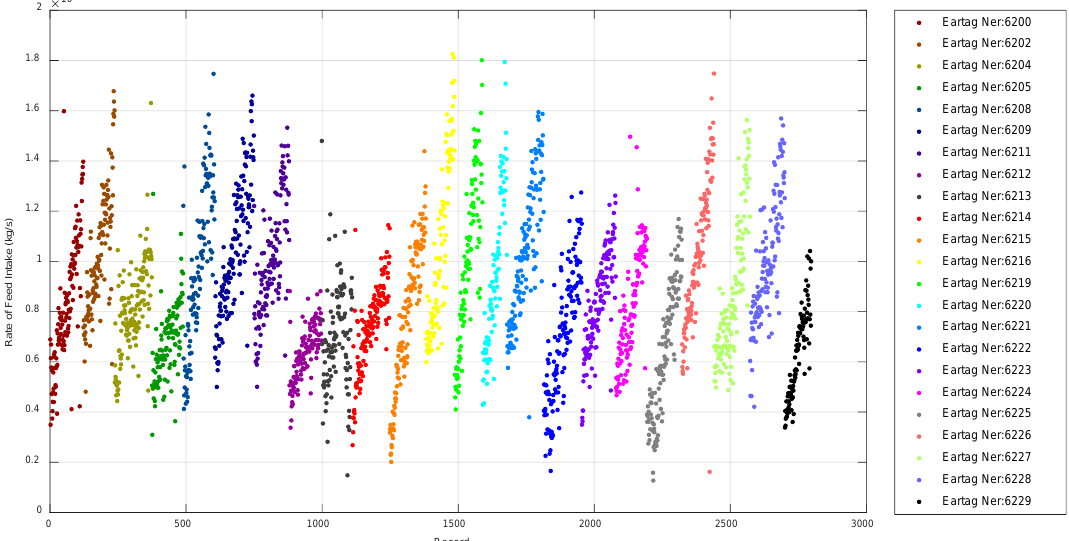
Figure 12. Evolution of the rate of feed intake during the whole fattening period for each monitored animal.